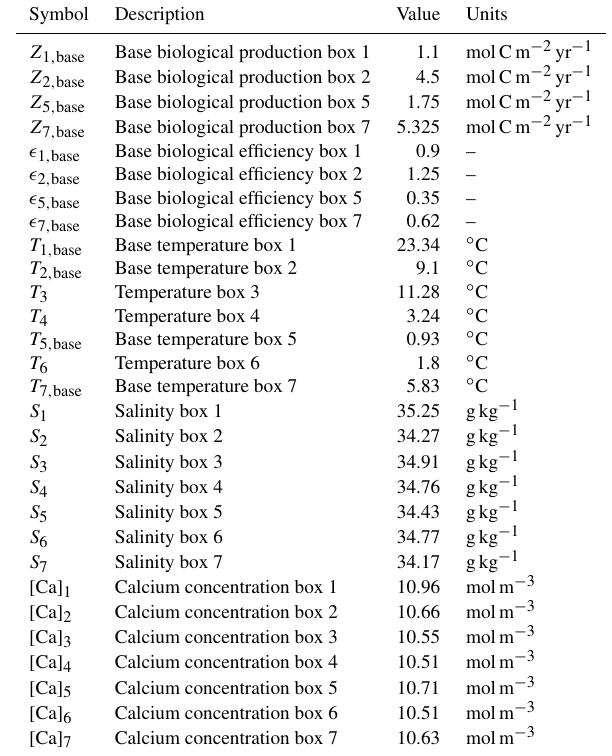
Table A3. Symbol (column 1), description (column 2), value (col- umn 3), and units (column 4) of the other parameters used in our model.